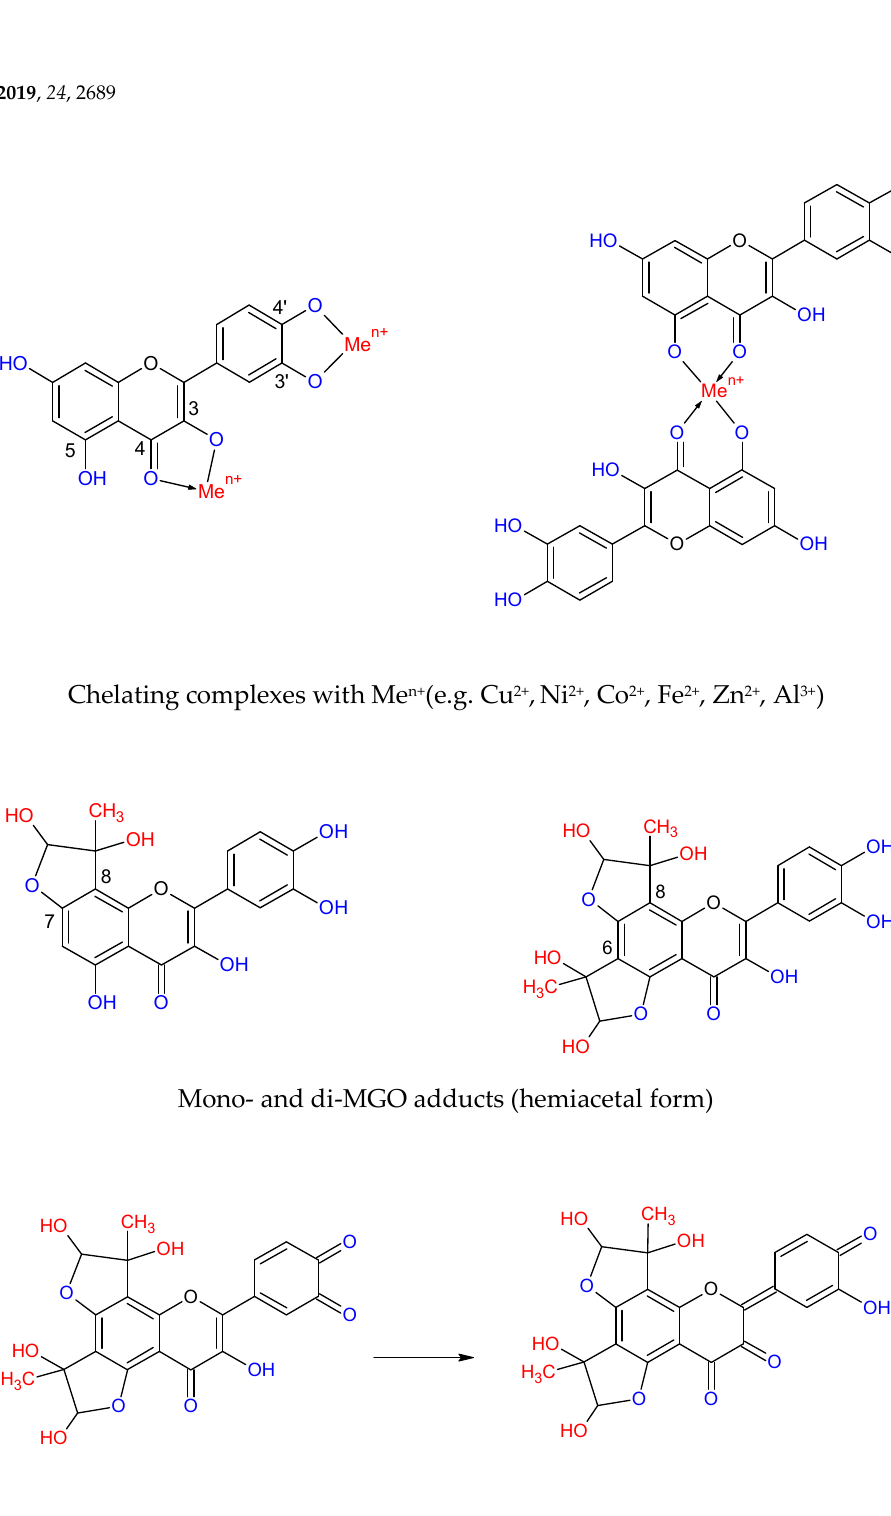
Figure 4. Possible chelating and trapping sites of quercetin, and exemplary structures of reaction products.